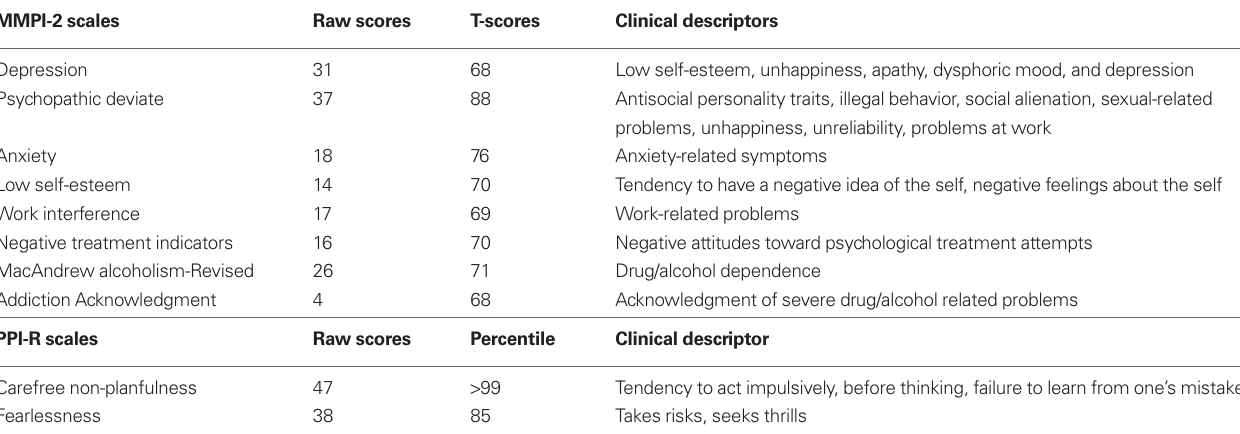
Table 1 | Scores of clinical interest in J.F.’s MMPI-2 and PPI-R profiles. MMPI-2